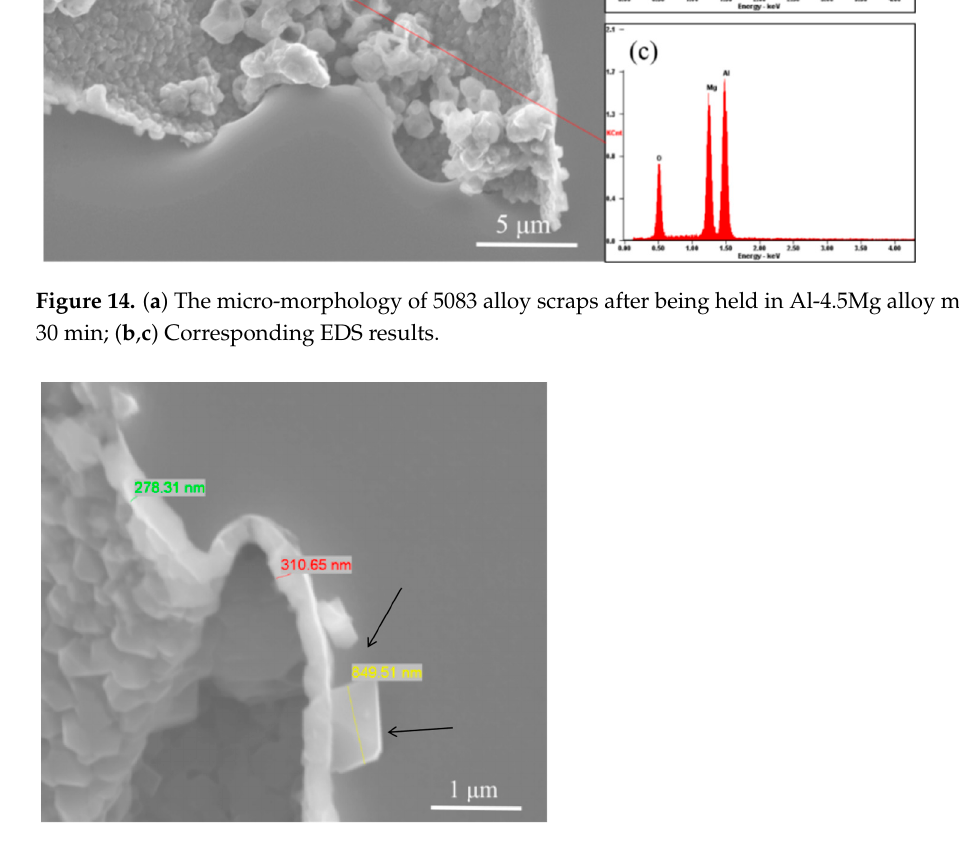
Figure 15. The morphology of cross-sectional of oxide film after being held in Al-4.5Mg alloy melt for 30 min.